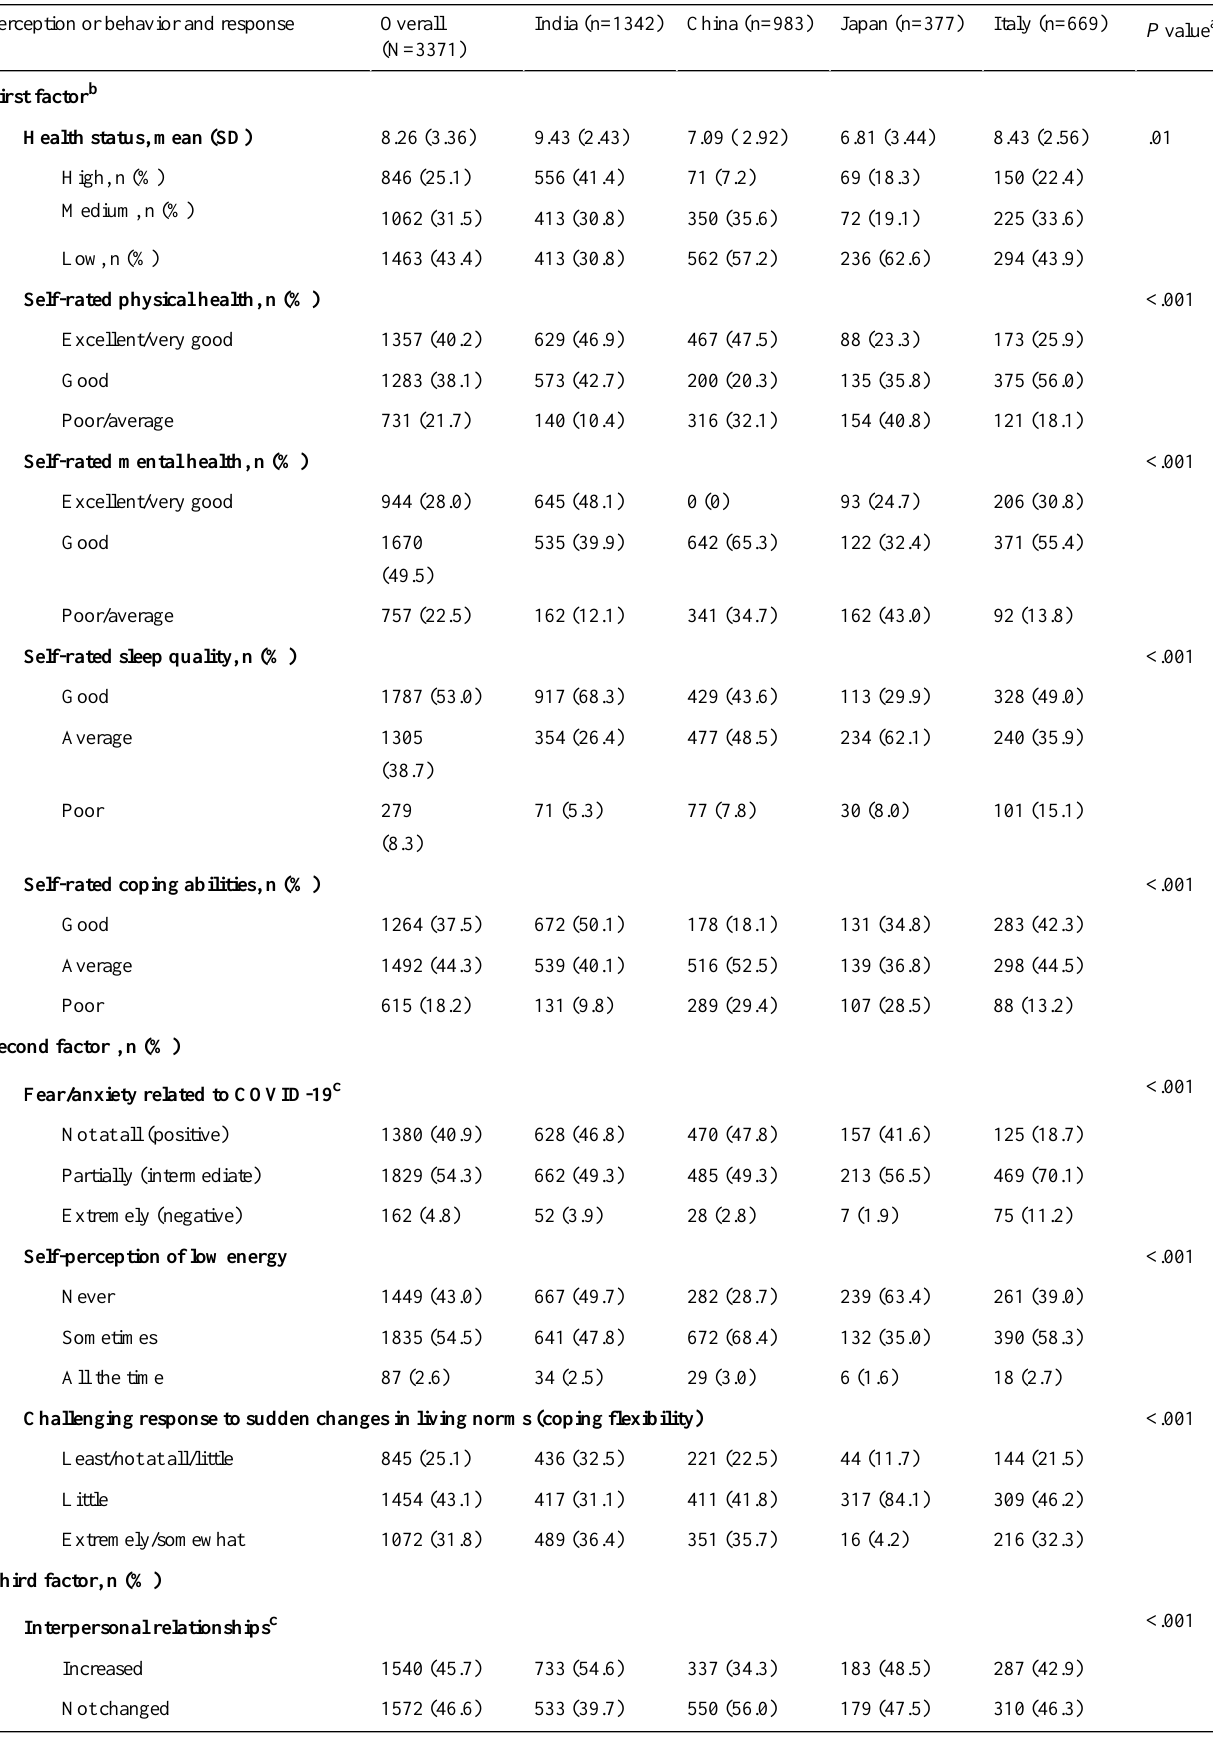
Table 2. Countrywise representation of perceptions and behavioral changes among the survey respondents related to the COVID-19